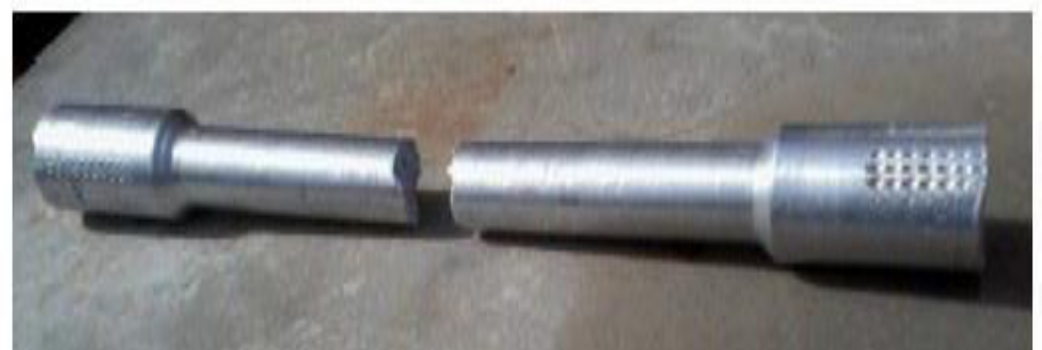
Fig. 10. Tensile test specimen after testing